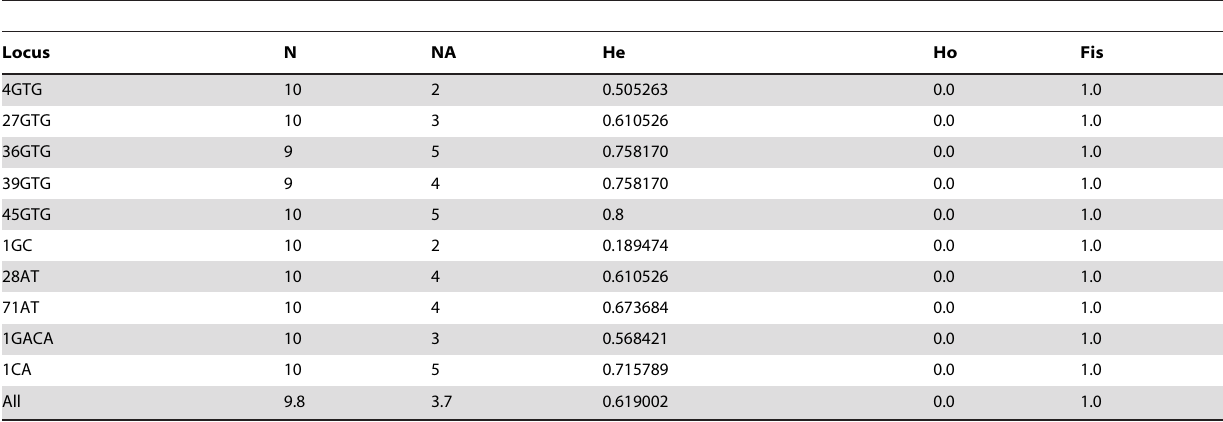
Table 2. Descriptive statistics revealing genetic characteristics and variation of the ten microsatellite loci detected in the population of 55 L. major strains isolated from Tunisian rodents and